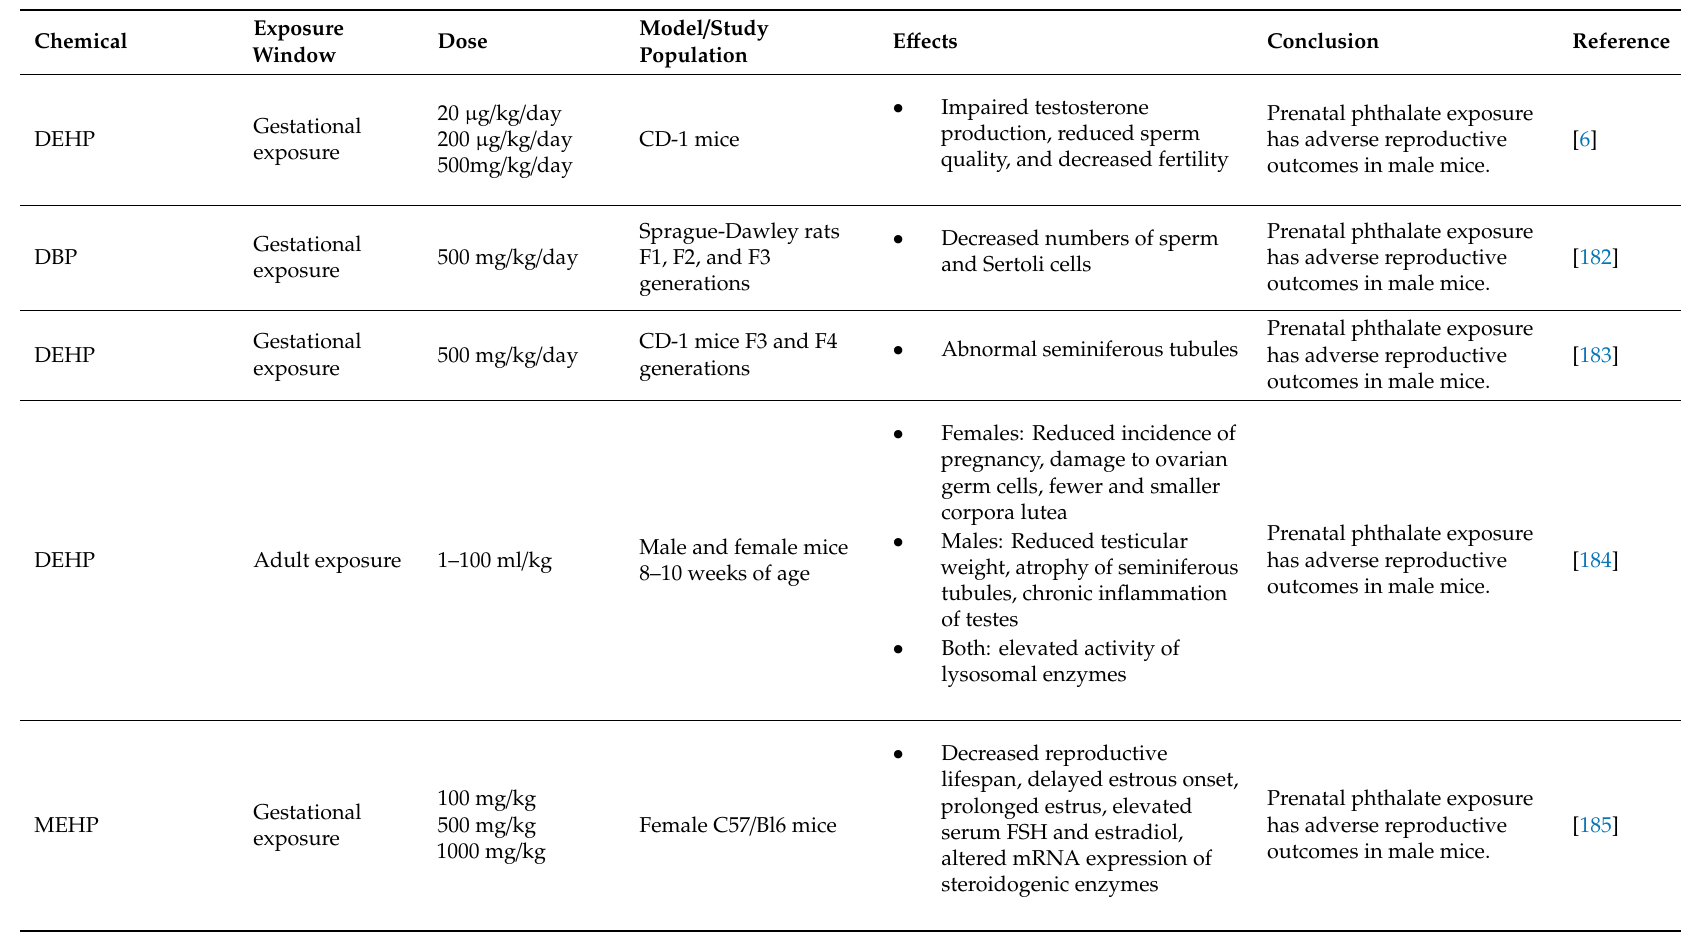
Table 6. E ff ects of Phthalates on the Reproductive